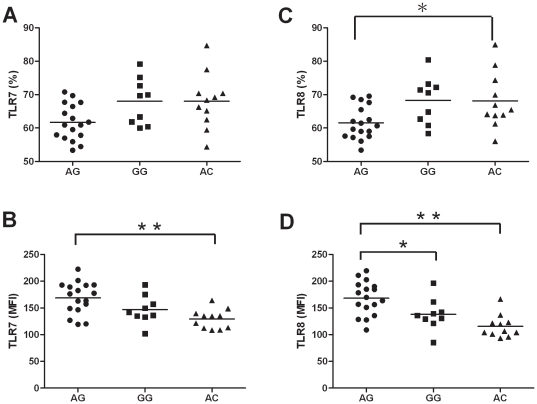
Intracellular TLR7 and TLR8 protein expression in monocytes of health male subjects with different genotypes of TLR7 and TLR8.The TLR7 and TLR8 protein expressions in monocytes of different genotypes from health male subjects were assessed by FACS. By double staining strategy with anit-CD14-PE conjugated antibody and monoclonal FITC conjugated TLR7 or TLR8 antibodies. (A) TLR7 expression represented as percentage of CD14-positive cells; (B) TLR7 expression represented as MFI; (C) TLR8 expression represented as percentage of CD14-positive cells; (D) TLR8 expression represented as MFI. Each dot represents an individual, (•) represent individuals with TLR7 IVS2-151A/TLR8 -129G genotype, (▪) represent individuals with TLR7 IVS2-151G/TLR8 -129G genotype and (▴) represent those with TLR7 IVS2-151A/TLR8 -129C genotype. The horizontal bars represent mean value. *: p-value<0.05. **: p-value<0.001.